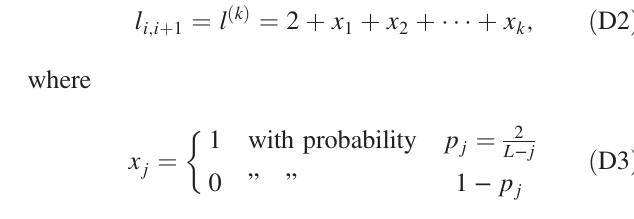
at α ¼ 0 . 3 res Þ